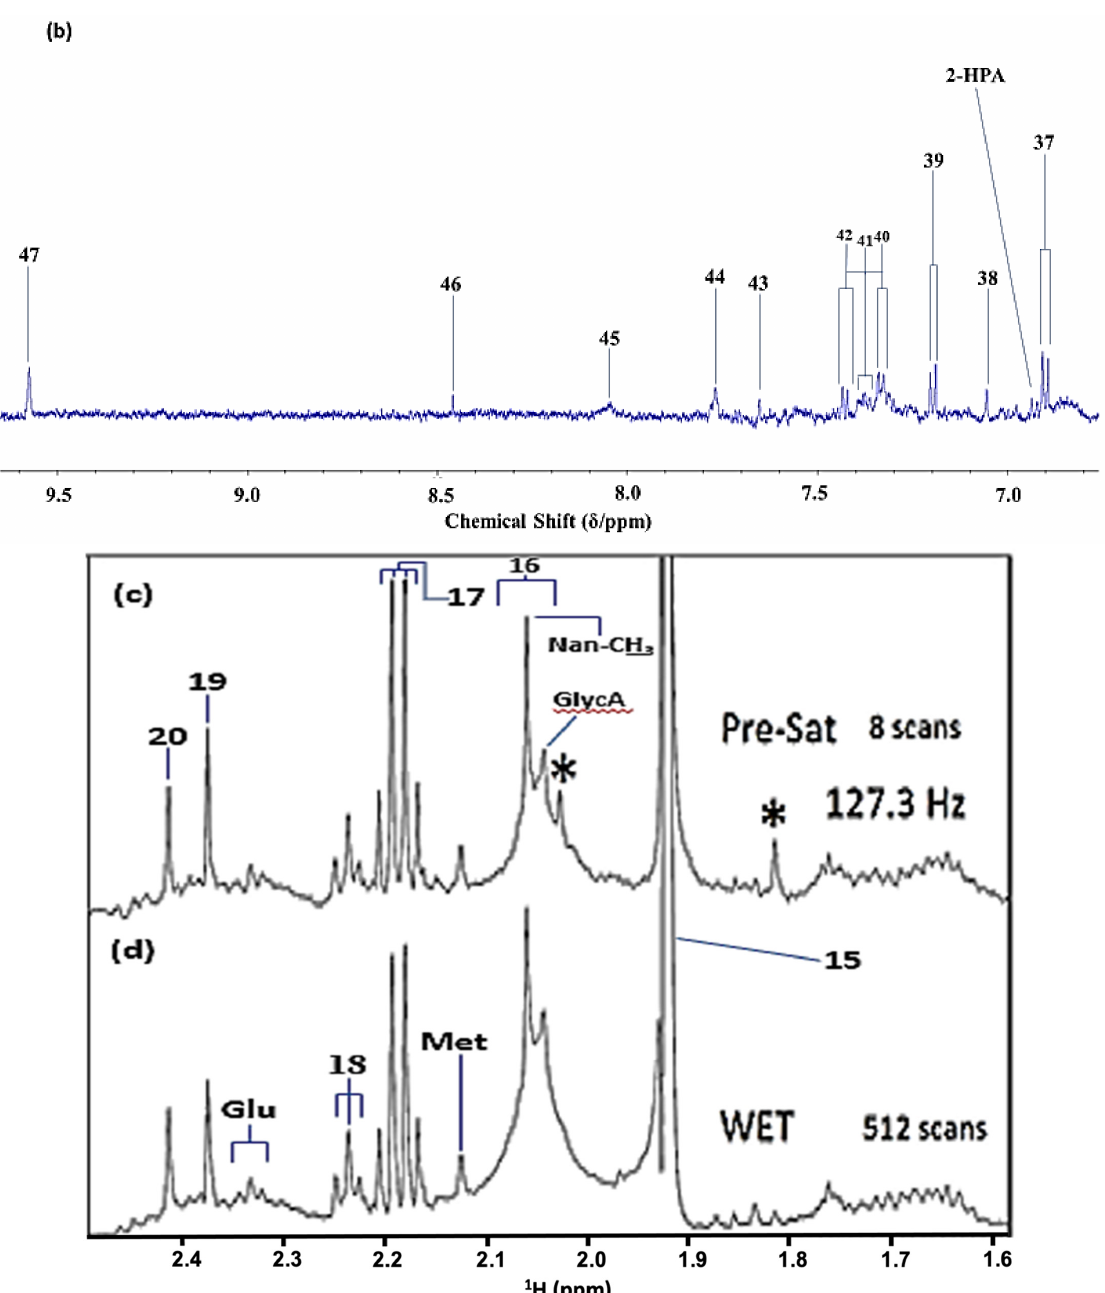
Figure 1. High-Resolution 1 H NMR Analysis of Human Salivary Supernatant Samples. ( a , b ), High- and low-field regions (0.70–4.40 and 6.75–9.65 ppm, respectively) of the 600 MHz noesy-presat 1 H NMR spectrum of a WMSS sample donated by a healthy human participant. Samples were prepared according to the methods described in Refs. [1,2], and contained added phosphate buffer to control pH, azide as a microbicide to curtail metabolite consumption/fermentation and catabolite generation by bacteria during periods of sample preparation and storage prior to analysis, and 250 µ mol./L TSP as a chemical shift reference ( δ = 0.00 ppm) and quantitative 1 H NMR standard. ( c , d ), 1.60–2.50 ppm regions of repeat noesy-presat and WET pulse sequence 1 H NMR profiles acquired on a human WMSS sample for 512 and only 8 scans, respectively. The noesy-presat or WET pulse sequences were employed to suppress the intense water resonance. Typical spectra are shown. Resonance assignment number codes and abbreviations are listed in Table 1. The asterisks in ( c , d ) represent 13 C satellites of the very intense WMSS acetate-CH 3 resonance. Table 1. 1 H NMR Resonance Assignments for Human WMSS Samples at an Operating Frequency of 600 MHz. * Broad resonance located at δ = 8.05 ppm, which along with those at ö = 6.85 and 7.55 ppm [1] (also visible in Figure 1b), presumably arise from salivary protein tyrosine, phenylalanine, tryptophan and/or histidine residues. ** This aldehydic proton (-C H O function) signal may be a singlet or a triplet; if a triplet, as in saturated aldehydes ( n -alkanals), without expansion it appears as a singlet in view of a very low J coupling constant value (1.4 Hz) [3]. Abbreviations: APP, acute- phase protein; s , d , t , q and m , singlet, doublet, triplet, quartet and multiplet resonance multiplicities, respectively.